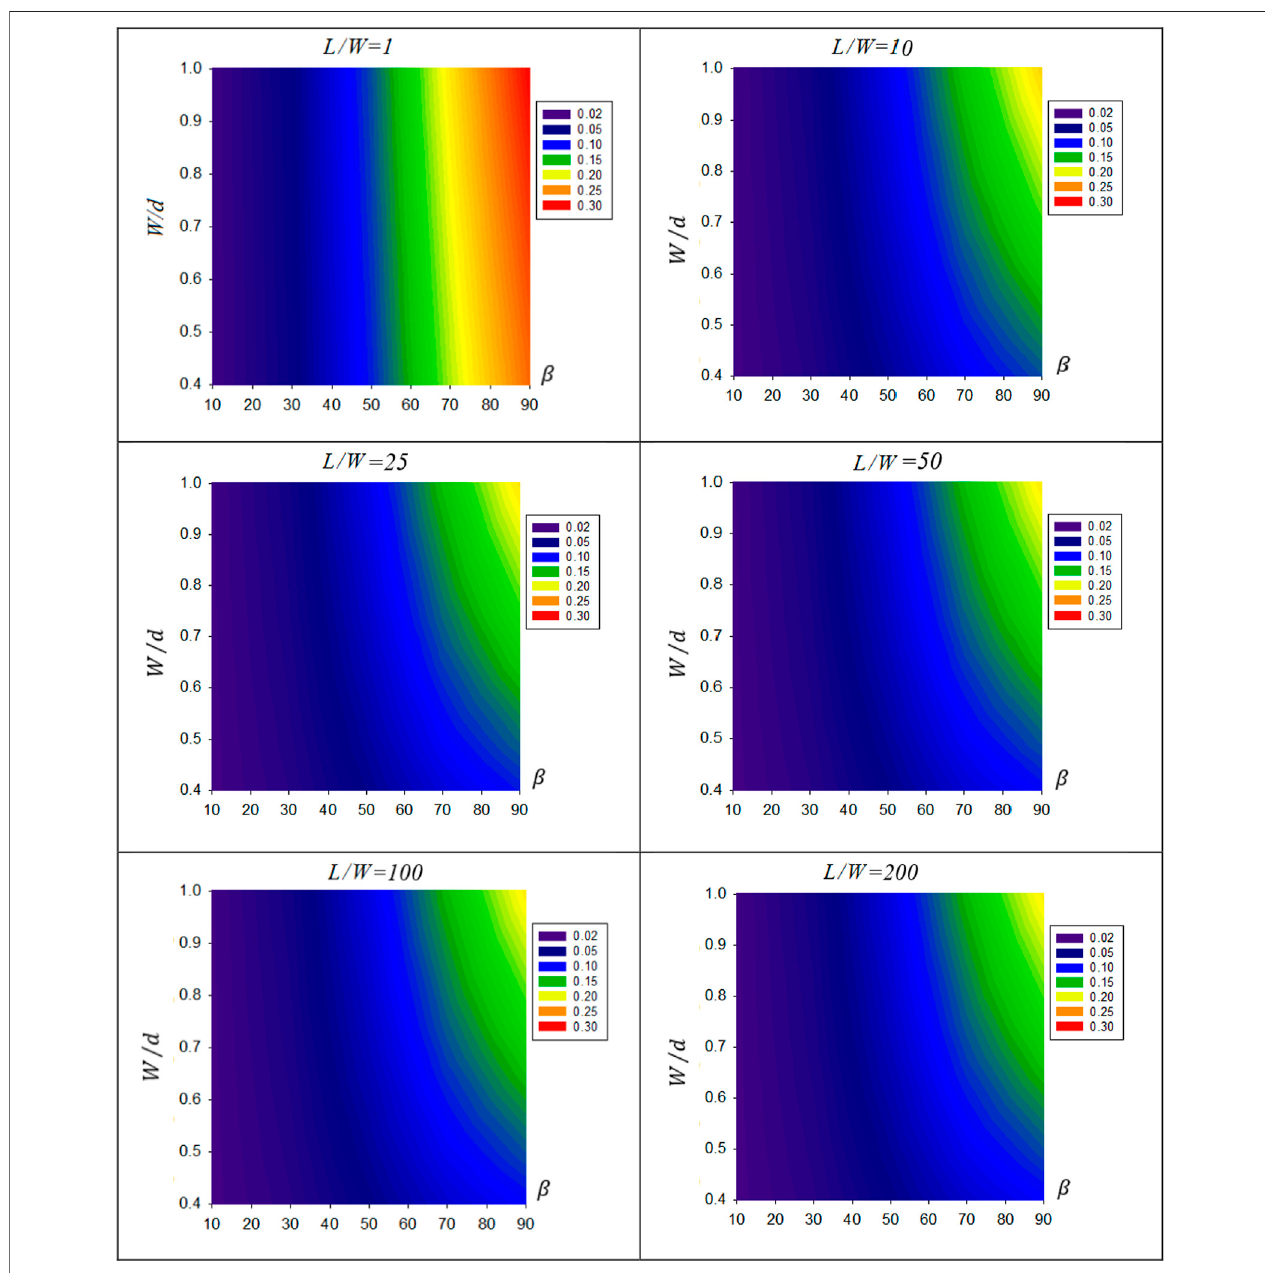
FIGURE 10 | Contour presentation of F A